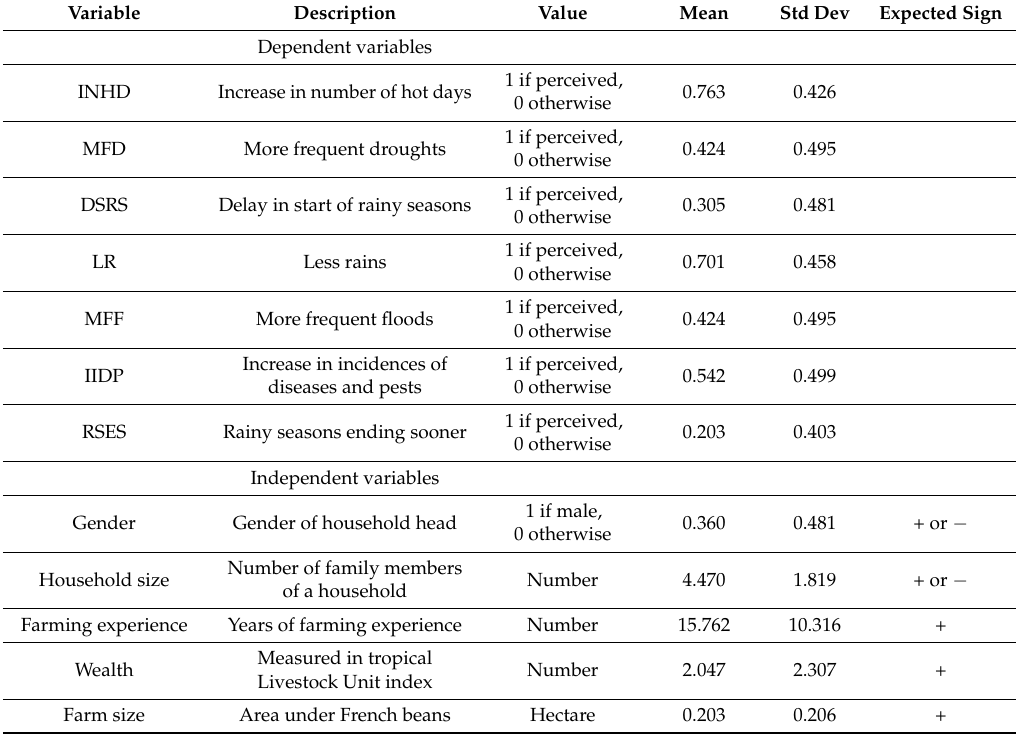
Table 1. Descriptive statistics of key variables and their hypothesized